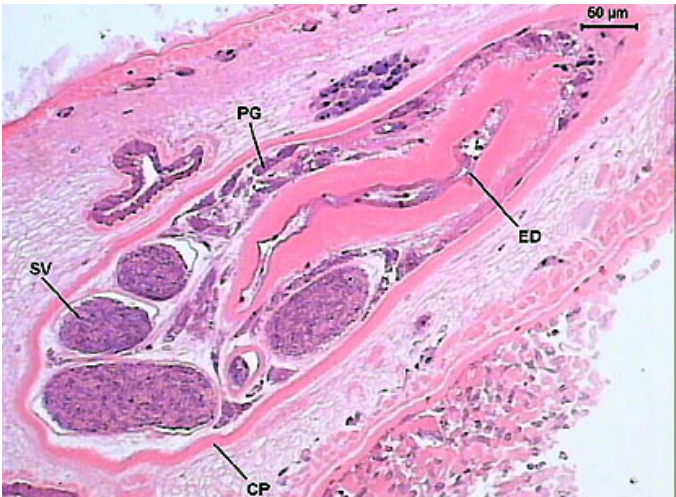
Figure 23. Transversal section of the Sticholecitha serpentis cirrus pouch. cirrus pouch, ED – espermatic duct, PG – prostatic glands, SV – seminal vesicle.